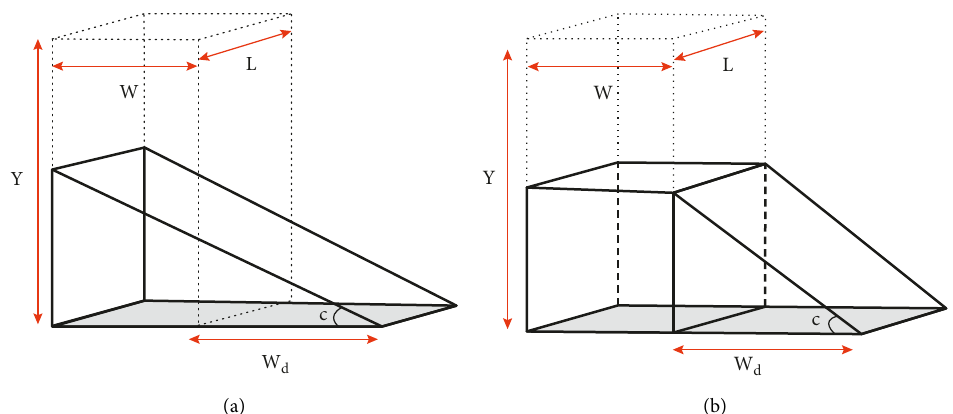
Figure 2: (a) Building collapse type 1. (b) Building collapse type 2 based on Argyroudis et al. [19].